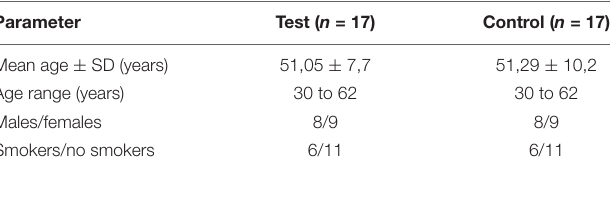
TABLE 2 | Values (mean ± SD) for Plaque and bleeding index and PD and CAL at Baseline and at 3 months. Parameter Interval Test